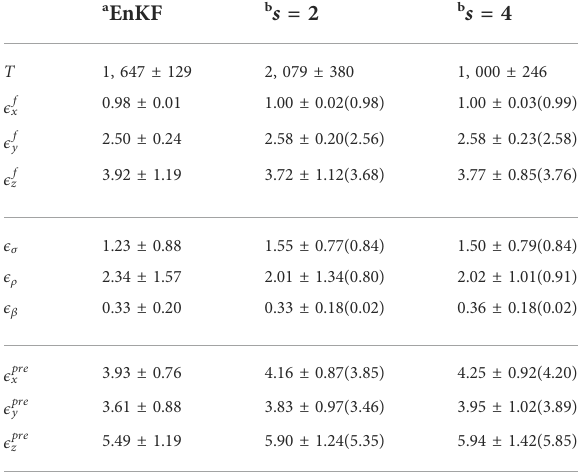
TABLE 2 Detail results of the Lorenz-63 system with unknown